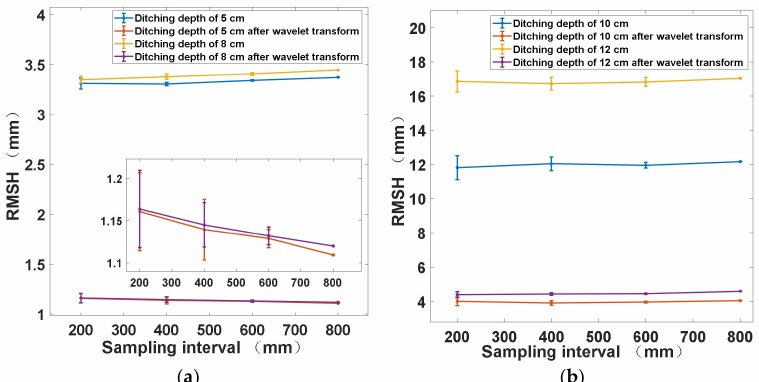
Figure 10. The roughness of soil surface before and after wavelet transform under different ditching depths and different sampling intervals. ( a ) Ditching depth of 5 and 8 cm. ( b ) Ditching depth of 10 and 12